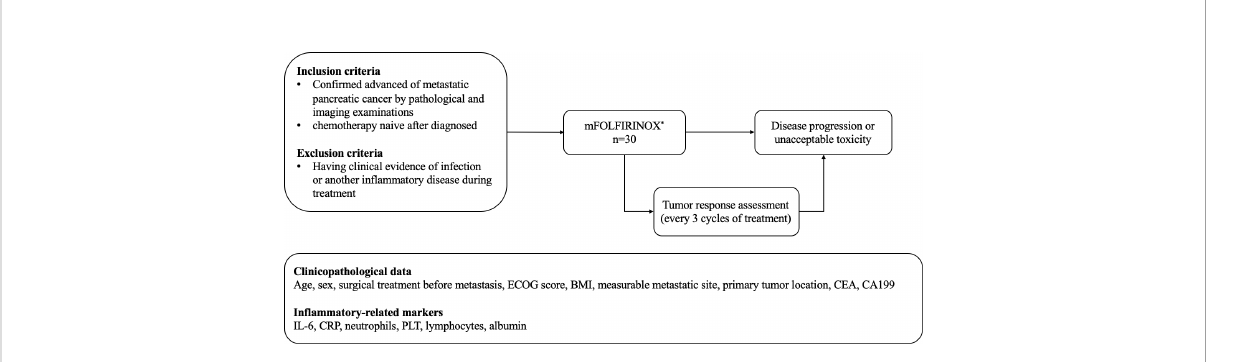
FIGURE 1 The mFOLFIRINOX regimen: oxaliplatin 68 mg/m 2 given as a 2-h intravenous infusion, then leycovorin 400 mg/m 2 delivered as a 2-h intravenous infusion, qnd fi nally 5-FU 2400 mg/m 2 given as a continous intravenous infusion over a 46-h period. The regimen had beeb administered on day 1 and the repeatedevery 2 weeks until disease progression or patient refusal. ECOG, Easteran Cooperative Oncology Group; BMI, body mass indez; CEA, carcinoembryonic antigen; CA199, cancerantigen199; IL-6 interleukin-6; CRP, C-reactive protein; PLT,